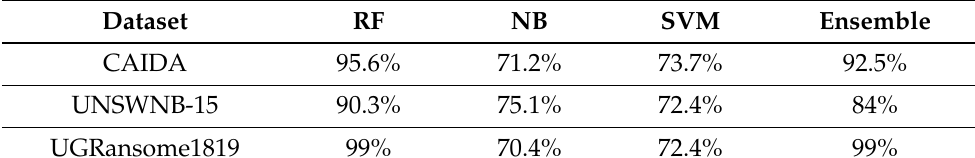
Table 10. Comparing the UGRansome1819’s Accuracy After Optimization.